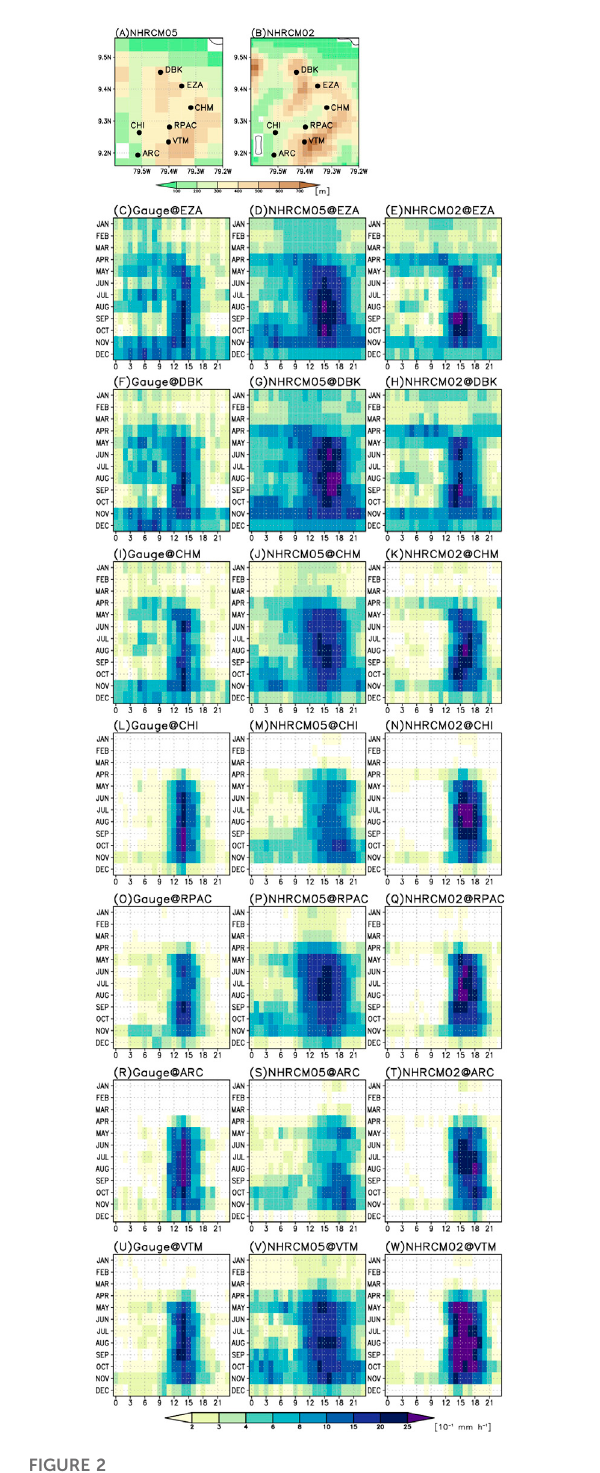
FIGURE 2 locations and elevation of NHRCM05 (A) and NHRCM02 (B) . The climatological diurnal change of precipitation in each month at the stations for rain gauges, NHRCM05, and NHRCM02 (C – W) . The shades indicate hourly